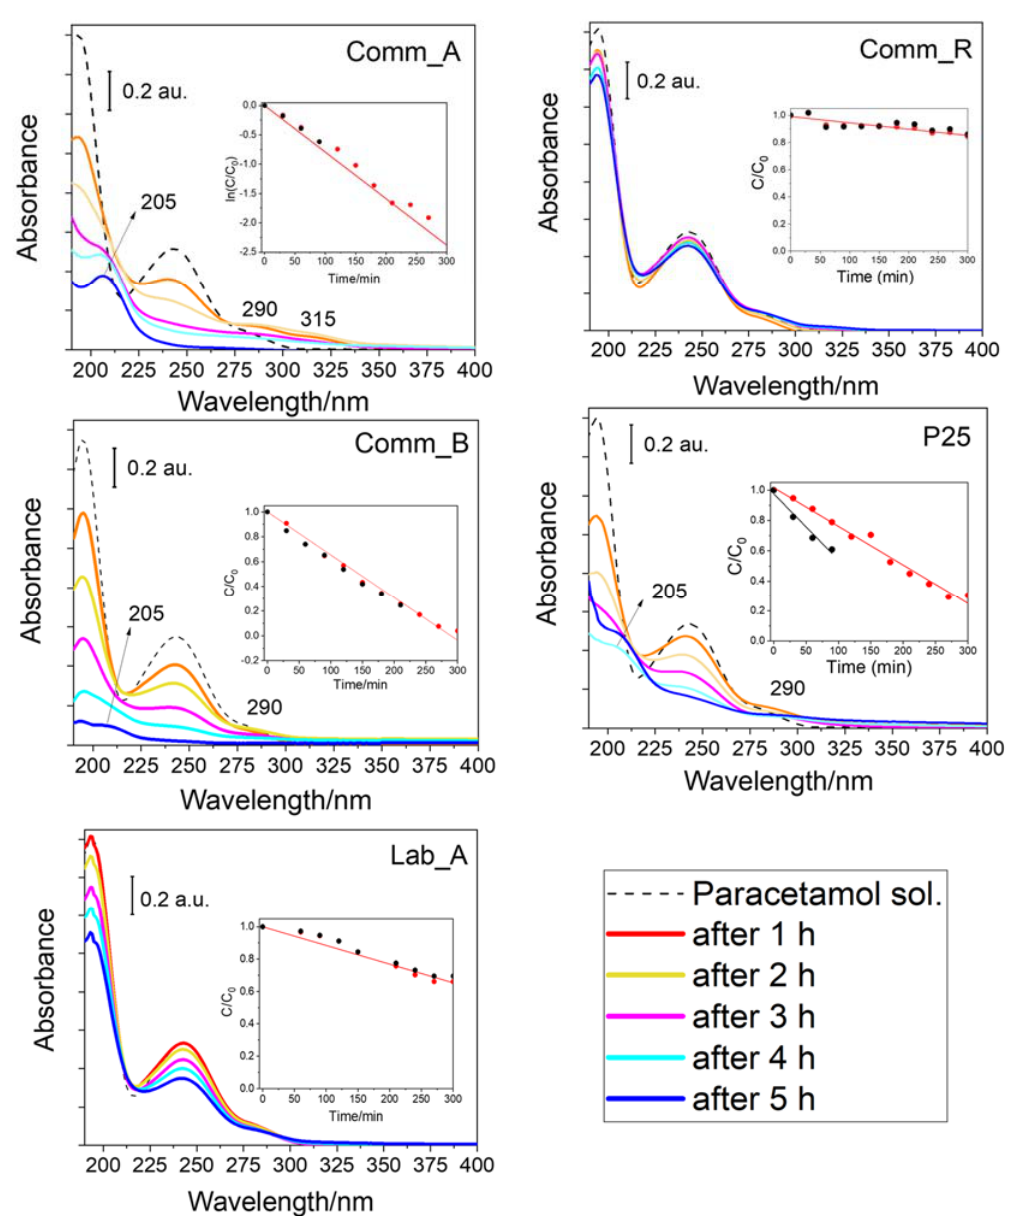
Figure 7. UV-Vis spectra of the starting 0.01 mM paracetamol solution and of the supernatant aliquots withdrawn after 1, 2, 3, 4, and 5 h solar illumination with the following samples: Comm_A, Comm_R, Comm_B, P25, and Lab_A. The photocatalyst concentration was 0.15 g L − 1 . The insets refer to kinetics curves as obtained by following the 243 nm band intensity (red symbols) and the 194 nm band (black